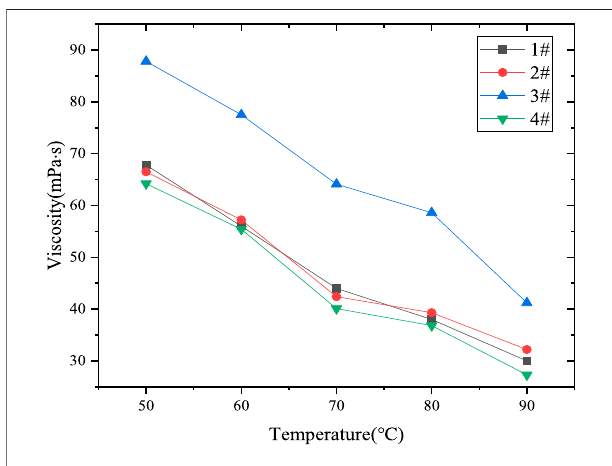
FIGURE 3 | Viscosity reduction effect of four viscosity reducers.